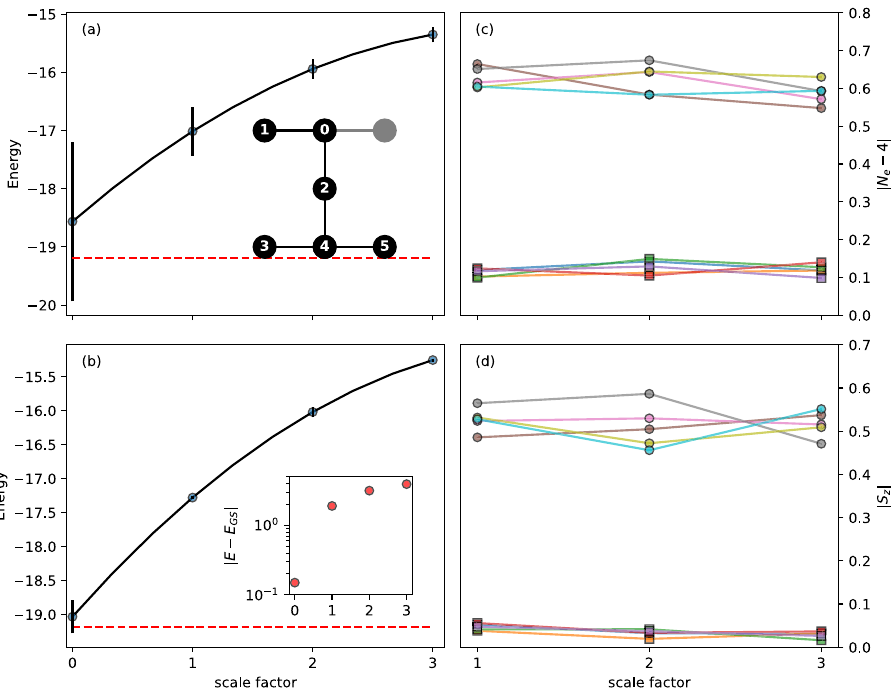
Fig. 8 Estimating ground state energy of the e g model on IBM device ibmq_casablanca . Richardson energy extrapolation is applied by a quadratic curve fi tting for three data points of increasing noise scale with averages over 10 runs in ( a ) and an optimal subset of 5 runs in ( b ). Distinct but equivalent hardware native circuits are associated with each run owing to the nondeterministic nature of local random unitary folding and transpilation. The average number of electrons N e and total spin z -component S z for each of the 10 runs in terms of their deviations from ideal values are plotted in ( c ) and ( d ), respectively. The optimal subset of fi ve runs is identi fi ed by smaller symmetry violations ∣ N e − 4 ∣ < 0.2 and ∣ S z ∣ < 0.1. The inset a shows the qubit layout of ibmq_casablanca . The dark numbered circles represent the qubits adopted in the calculation with that particular order. Inset in b : the energy error Δ ( E ) = ∣ E − E ∣ in log scale. The error bar denotes the standard deviation of the sample GS